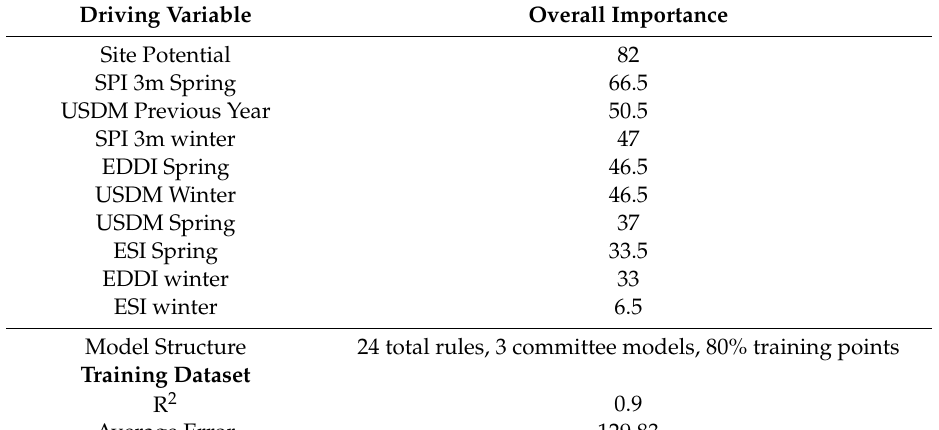
Table 4. Driving variables and their overall importance in the late spring biomass model (Model 2). Overall importance was calculated as a mean of frequency of usage in model stratification and prediction (%).